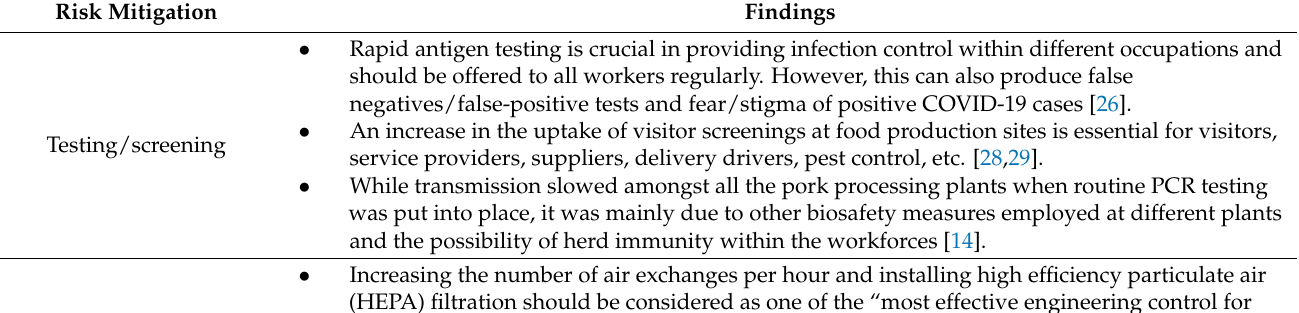
Table 4. Summary of main risk mitigations found in the literature. Risk Mitigation Findings